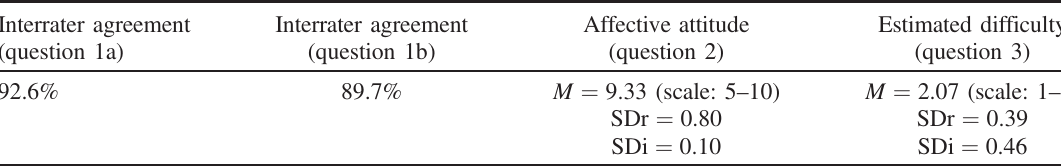
TABLE I. Raters ’ opinions on FBDT — results of the teacher survey; M is the mean value, SDr the standard deviation of raters ’ average ratings, and SDi the standard deviation of the items ’ average ratings; i.e., SDr is a measure of between-rater variability and SDi is a measure of between-item